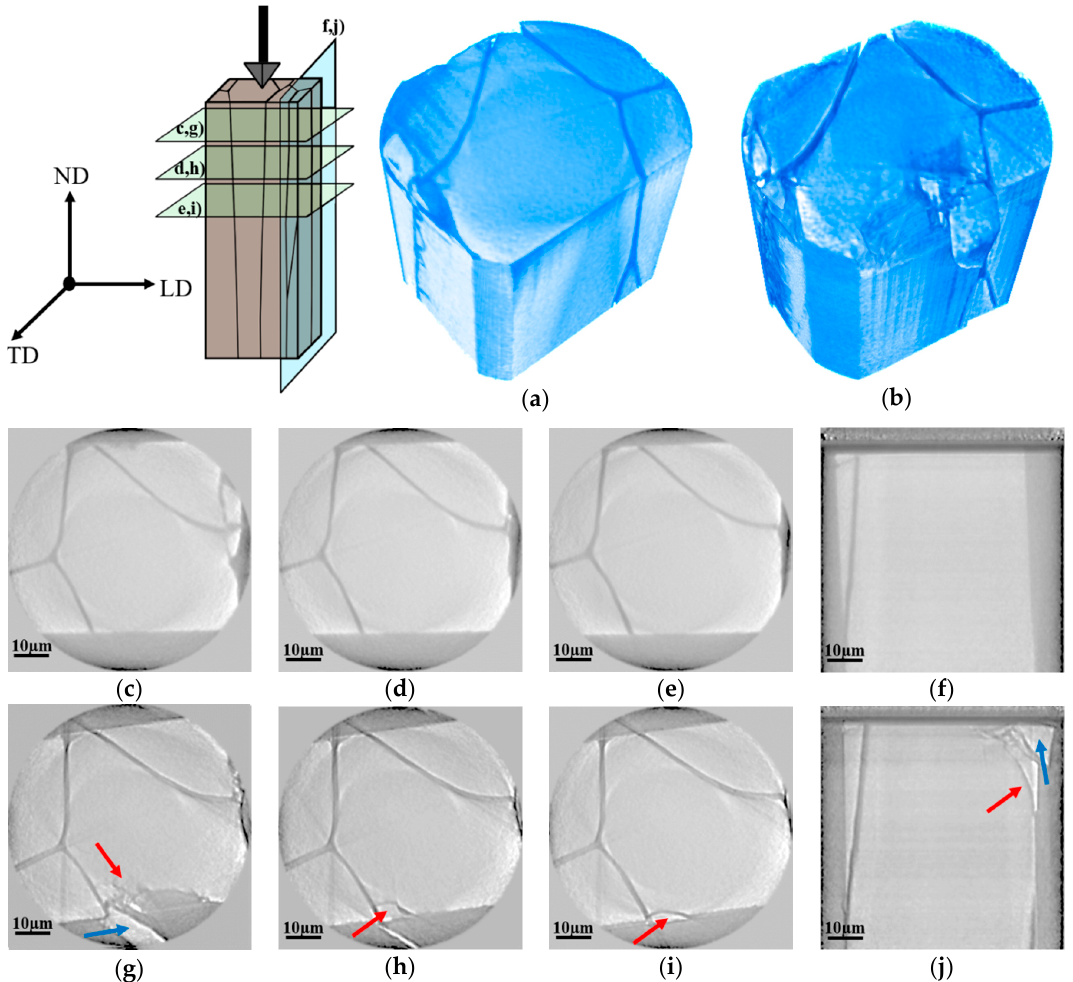
Figure 6. Scheme of in-situ X-Ray Computed Tomography indentation of P. margaritifera shells along ND, 3D reconstruction of the sample before ( a ) and after ( b ) in-situ indentation test; horizontal and vertical virtual cross-sections of the shell acquired before ( c – f ) and after ( g – j ) the indentation test (red arrows point to the cracks, while blue arrows show part of the material damaged during the test).